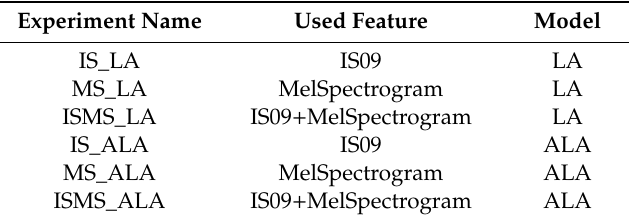
Table 2. Specification of each